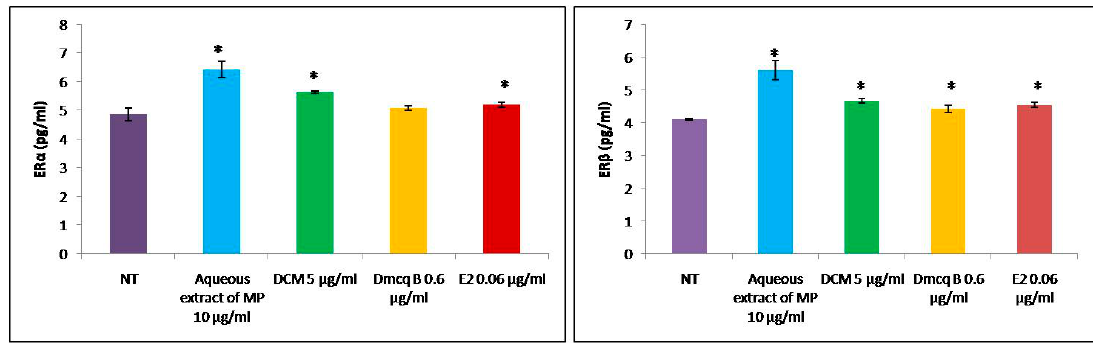
Figure 11. Effects of M. pumilum var. alata crude aqueous extract, DCM fraction, Dmcq B and E2 (positive control) on ER α and ER β which were present on osteoblasts after 72 h of